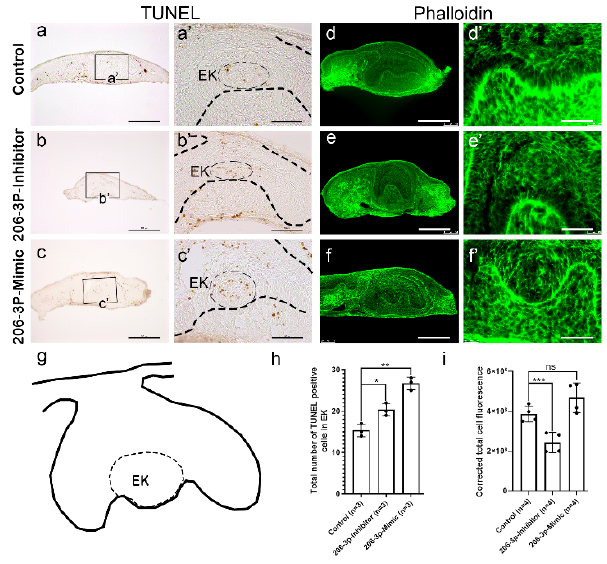
Figure 3. Cellular death and rearrangement after loss-and gain of function of miR-206-3p . Compared with the control ( a – a’ ), TUNEL assay showed that epithelial and mesenchymal apoptosis were increased after inhibiting miR-206-3p ( b – b’ ). Apoptosis especially increased in the EK after inhibiting miR-206-3p (b’, h). The mimic-treated specimen showed increased apoptosis in the epithelium, including EK, ( c – c’ ) but not in the IEE. Cell rearrangement patterns were examined using phalloidin staining (d-f). Phalloidin staining intensity is decreased in the tooth organ after inhibiting miR-206-3p ( e – e’ , i ) compared with that in the control ( d – d’ , i ). However, the staining intensity was not alteredin the mimic-treated specimens ( f – f’ , i ). Schematic of tooth organ with EK ( g ). EK; enamel knot. Boxes denote the magnified regions (a-c). Dotted lines indicate the epithelial boundary ( a’ – c’ ) and dotted ovals and or circles indicate the EK region ( a’ – c’ , g ). ns, *,** and *** indicate not significant, p < 0.05, p < 0.01 and p < 0.001, respectively. Scale bars 200 µm ( a – f ), 50 µm ( a’ – f’ ).